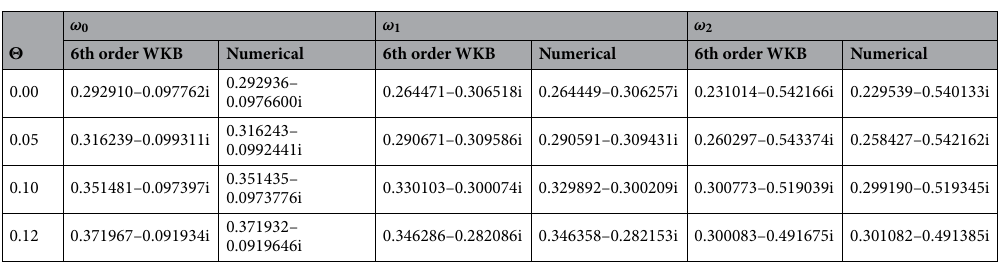
Figure 2. Transmission coefficients for three multipole l approximation between the two methods is very good.